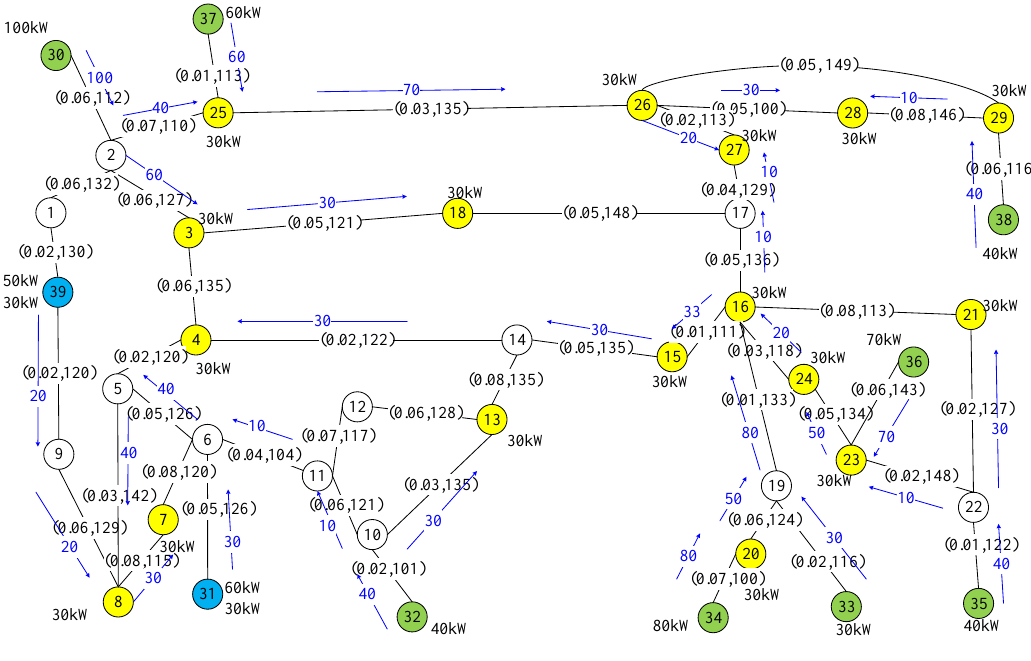
Figure 13. Path selection and source-load matching performed by GRASP on the IEEE39 bus.